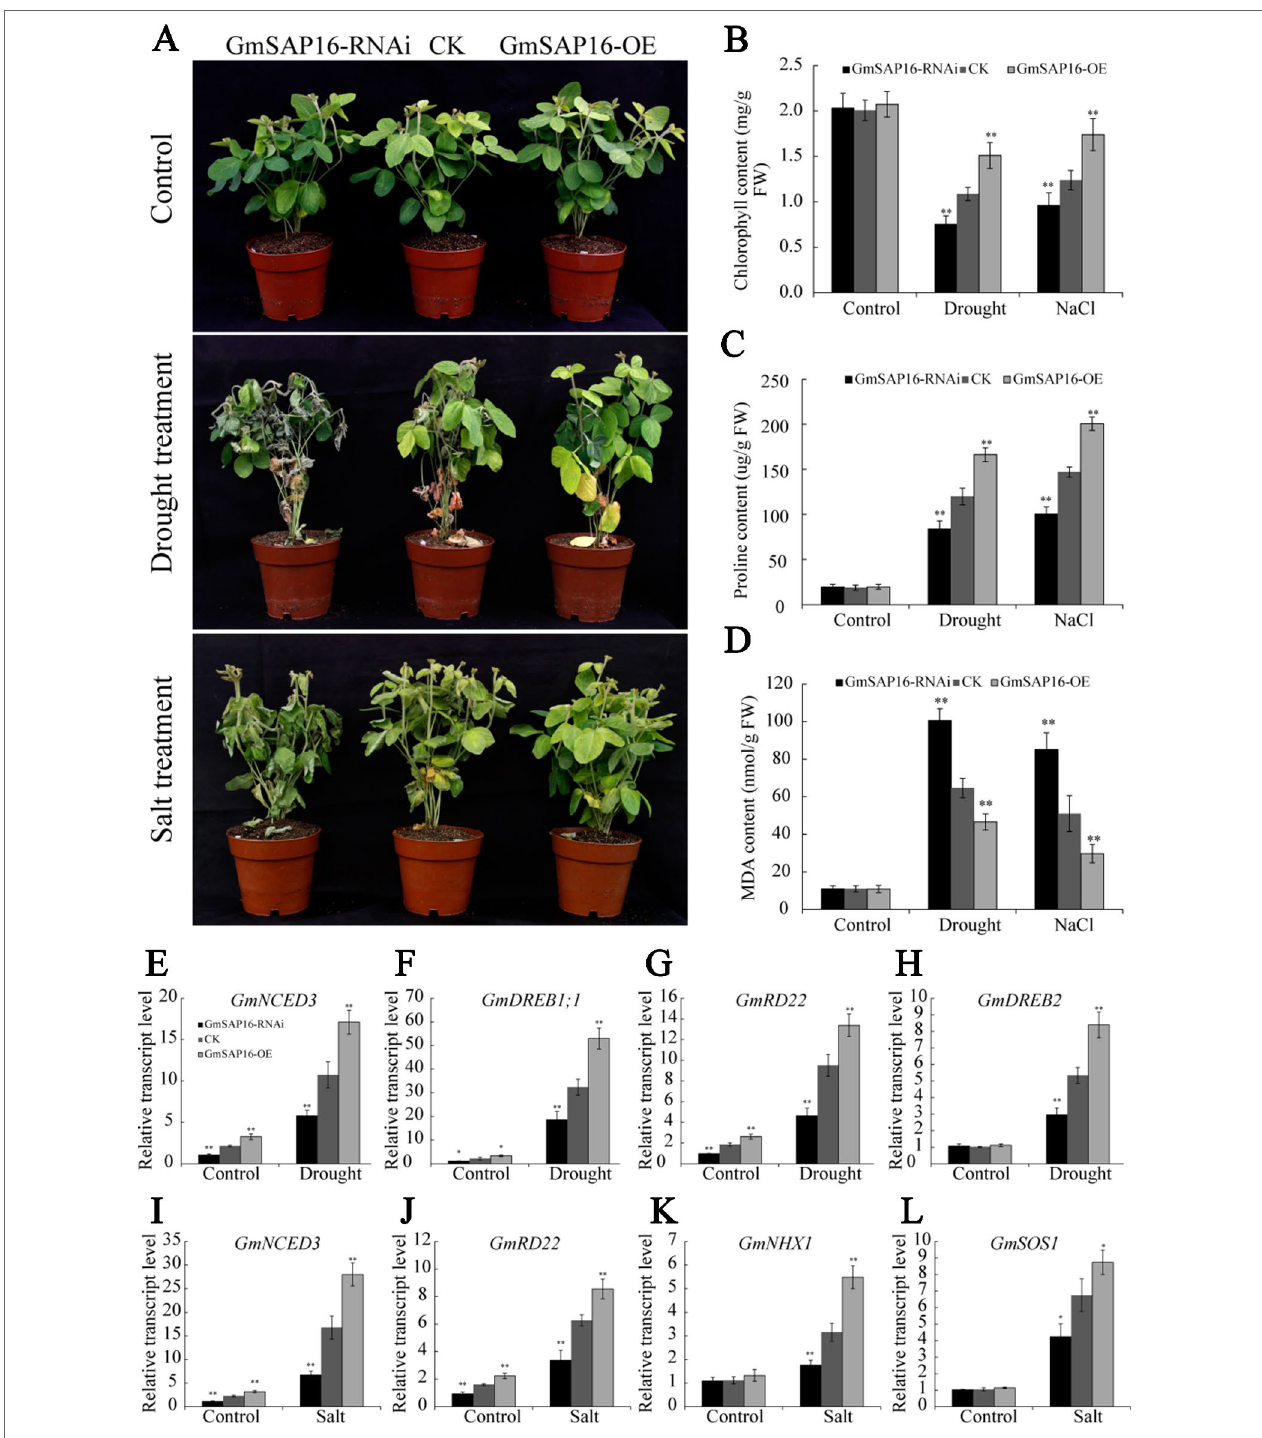
FiGURe 13 | Overexpression of GmSAP16 in soybean root hairs improves drought and salt tolerance. (A) Drought and salt-tolerance phenotypes of GmSAP16 transgenic soybean. The plants of different genotypes with 2–5 cm infected hairy roots were cultured under normal conditions for 5 days and then dehydrated for 2 weeks or treated with 250 mM NaCl for 1 week. Statistical analysis of the chlorophyll (B) , proline (c) , and MDA (D) contents of CK and GmSAP16 transgenic plants under normal and stressed conditions. The leaves of different genotypes were detached and measured after treatments. (e – l) Expression profiles of several stress- related genes in empty control and transgenic soybean plants under drought or salt stress. Error bars indicate the SD of three biological replicates Asterisks indicate statistical significance (*, P 0.05; and **, P 0.01; Student’s t test) compared with the corresponding controls.